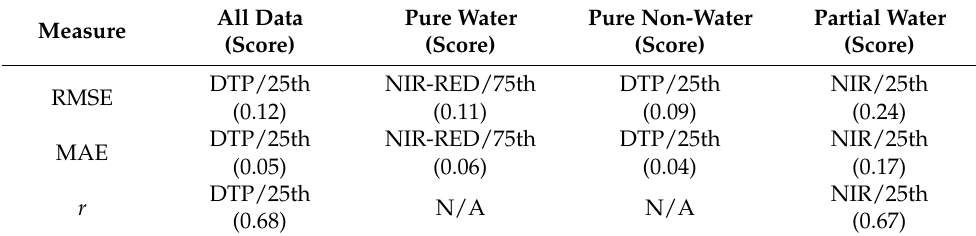
Table 2. Optimal parameter settings for pixel coverage categories.